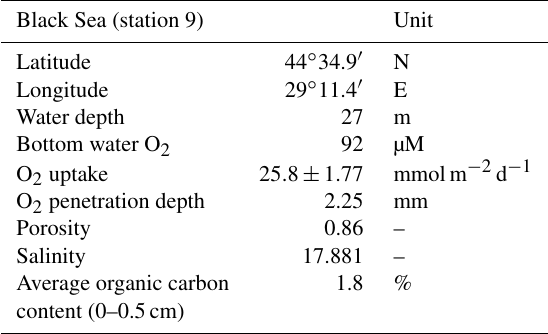
Table 1. Key site characteristics, including latitude, longitude, wa- ter depth, bottom water O 2 concentration, in situ O 2 uptake, in situ O 2 penetration depth in the sediment, porosity, salinity and aver- age organic carbon content for the upper 0.5cm of the sediment. These data were retrieved from Lenstra et al. (2019). Our study site is station 9 in Lenstra et al.